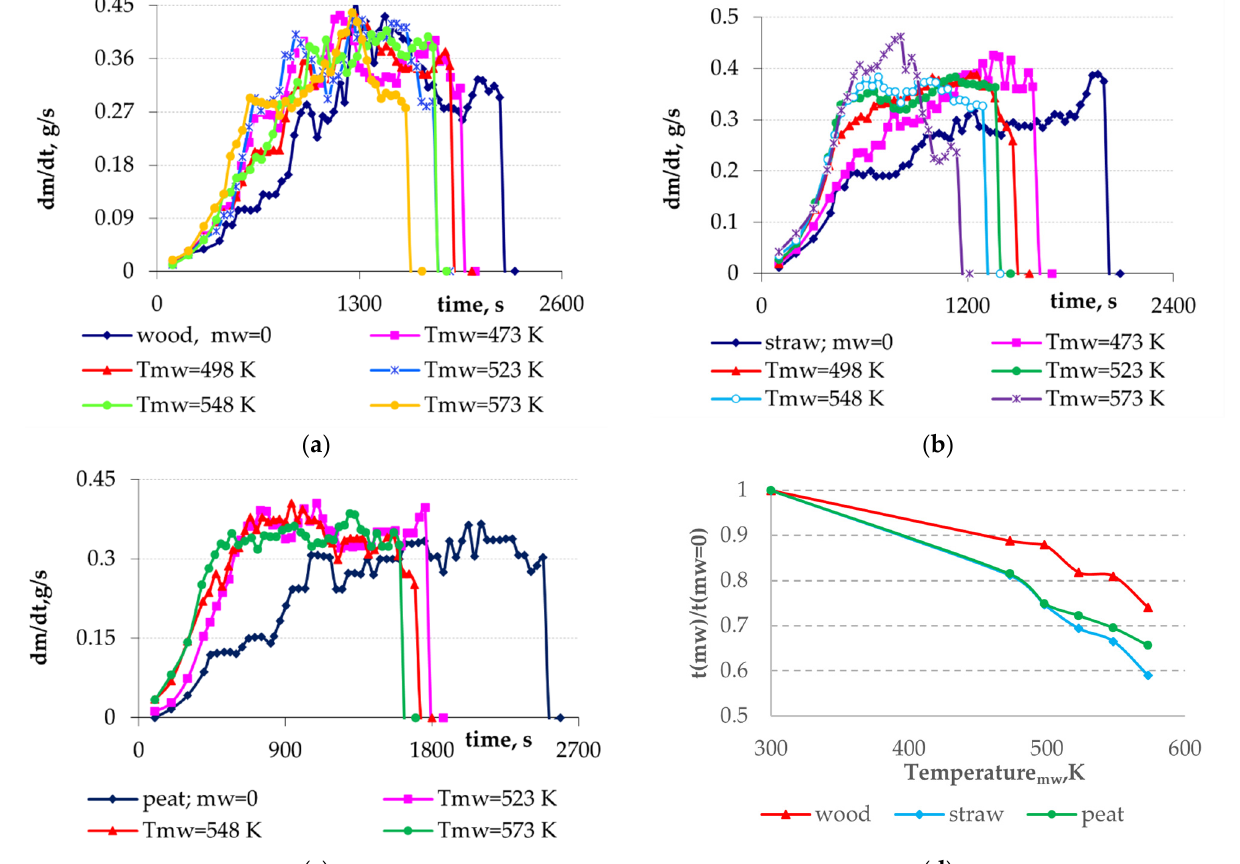
Figure 5. The effect of increasing the pretreatment temperature on the kinetics of the weight loss rate during the thermal decomposition of the pretreated pellets ( a – c ) and relative duration of the thermal decomposition ( d ).